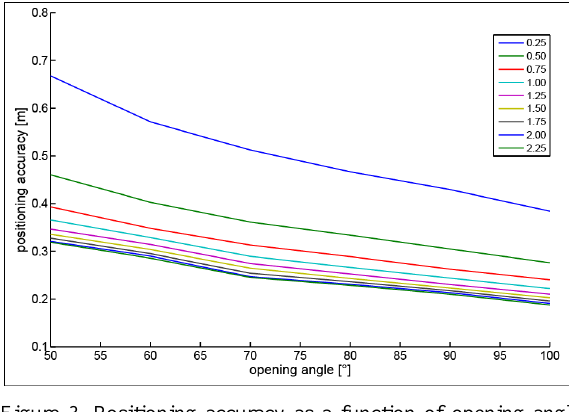
Figure 3. Positioning accuracy as a function of opening angle and base length (between 0.25 m and 2.25 m, see legend in upper right